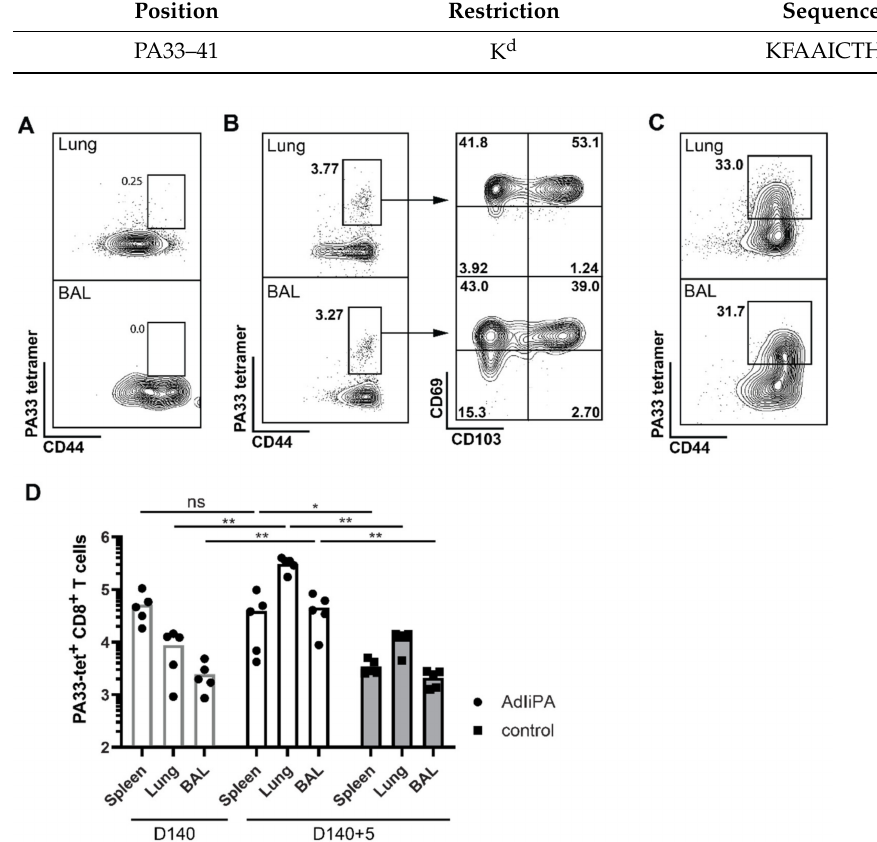
Figure 4. Identification of a novel K d epitope PA33. BALB/C mice were immunized with AdIiPA, and 140 days later, spleens, BAL, and lungs were isolated, and single cells were analyzed by flow cytometry. ( A ) Representative staining of K d PA33 tetramer+ T cells in naïve mice. ( B ) Representative staining of K d PA33 tetramer+ T cells and TRM markers CD69 and CD103 in lung and BAL. These are gated on intravenously stained negative and CD8+ cells. ( C ) Representative plots of tetramer staining in lung and BAL in AdIiPA-immunized mice five days after influenza challenge. ( D ) At 140 days post-immunization, mice were challenged with influenza, and five days post-challenge, spleen, BAL, and lung were isolated and PA33 tetramer+ cells were analyzed by flow cytometry. Total number of PA-specific CD8+ T cells were enumerated by D140 and D140 + 5 days post-challenge. Graphs are representative of experiments repeated twice with similar results. * = p < 0.05, ** = p < 0.01, ns = non